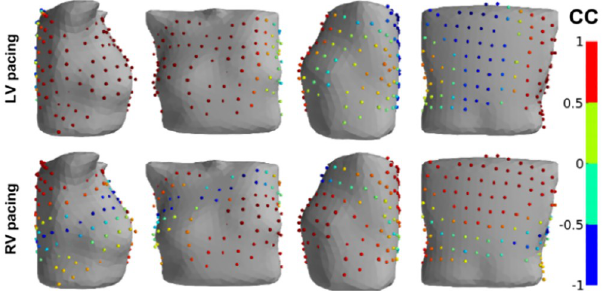
Fig 2. An example of a body-surface electrode array (spheres on the electrode locations) with a color-coded map of the CC between simulated and measured ECGs for patient P1 at LV (upper panels) and RV (lower panels) pacing. The color scale indicates a CC value from -1 (blue) for no correlation to +1 (red) for the highest correlation. The cases show two frequent patterns of regions with low correlation. The top panel (P1(LV) model) shows a single oval-shaped region of low CC on the left side of the spine, while the low panel (P1(RV) model) shows an elongated, band-shaped region of low CC around the torso.